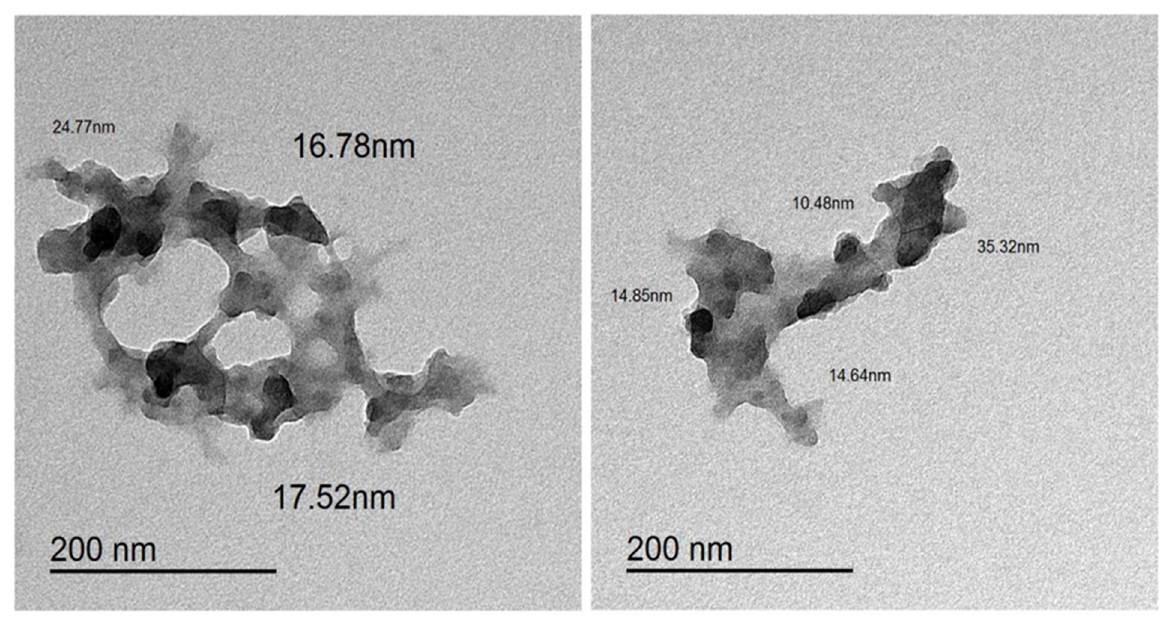
Figure 4. TEM micrographs of zinc oxide nanoparticles synthesized using pomegranate peel extract.